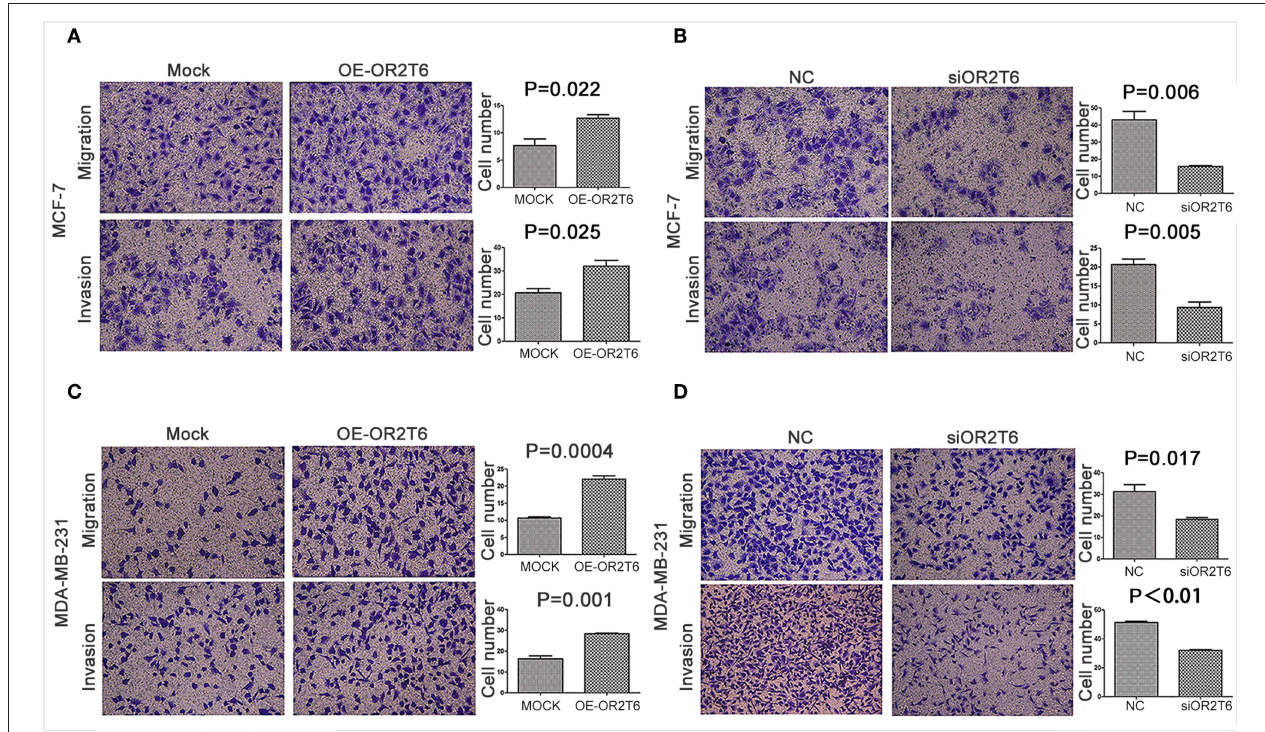
FIGURE 4 | OR2T6 enhances cell migration and invasion of breast cancer cell lines. Cells (1 × 10 5 ) were seeded in 12-well plates the day before transfection. After 24h of transfection, the cells (1 × 10 4 ) were resuspended in serum-free medium and seeded to the upper chamber of a Boyden chamber Transwell. Culture medium containing 10% fetal bovine serum was added to the lower chamber. Then, 36h later, any cells that had migrated were fixed, stained, and counted. For the invasion assay, an experiment was done using membranes coated with a Matrigel matrix. The migration and invasion of MCF-7 and MDA-MB-231 cells were increased by overexpression of OR2T6 (A,C) and decreased by interference with OR2T6 expression (B,D) . Student’s t -test was used to compare the difference between the two groups. Results were representative of triplicate